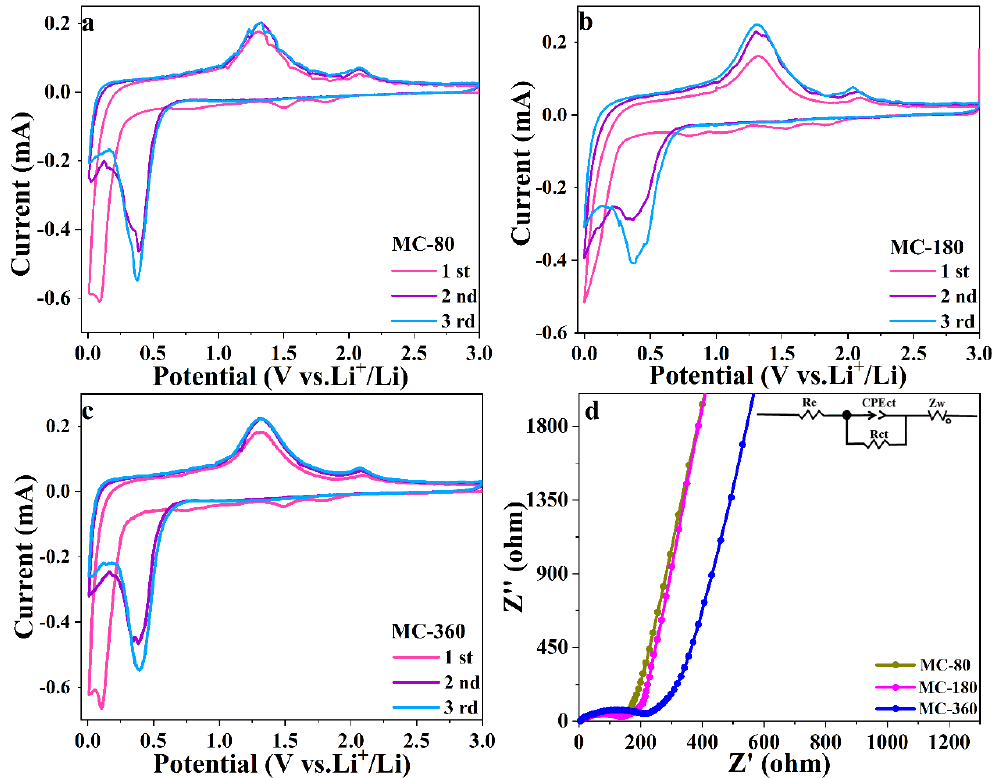
Figure 7. CV (cyclic voltammetry) curves of MC-80 ( a ), MC-180 ( b ), and MC-360 ( c ) at a scan rate of 0.1 mV s − 1 . ( d ) Nyquist plots of fresh cells for MC-80, MC-180, and MC-360, and the inset is the equivalent circuit.